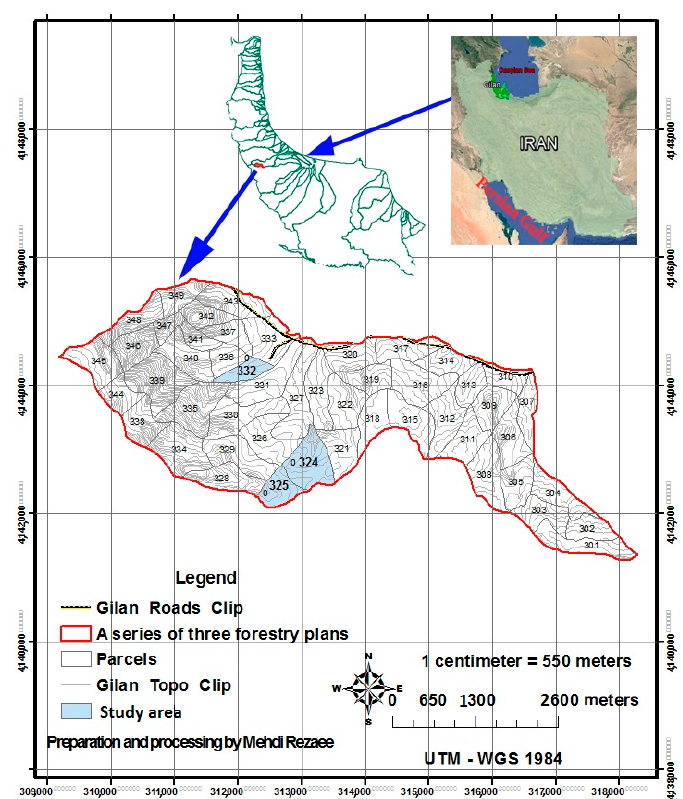
Figure 1. Study area in Hyrcanian forests of Iran.